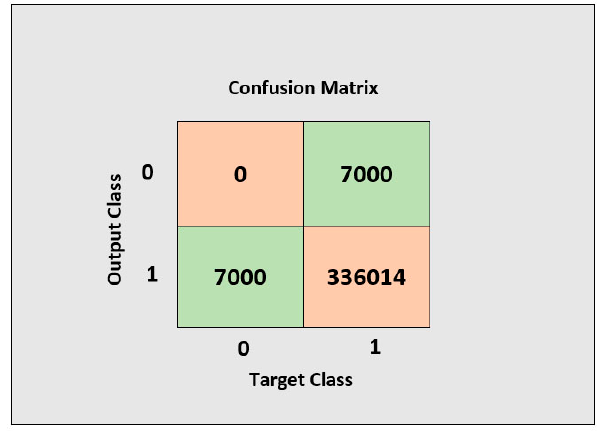
Figure 10. Confusion matrix of the AHA classified beats.